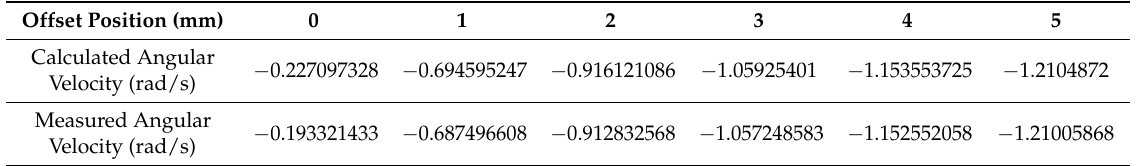
Figure 18. The angular velocity of the ankle joint in the support leg for different offset positions. Low stiffness spring constant = 50 N/mm. High stiffness spring constant = 800 N/mm. Table 2. Estimated and measured final angular velocity for different